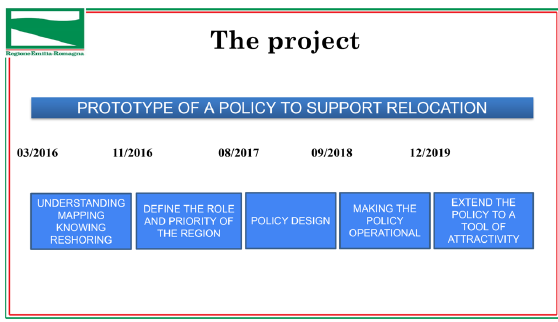
Fig. 2. Project Structure, adapted from the documental repository of the